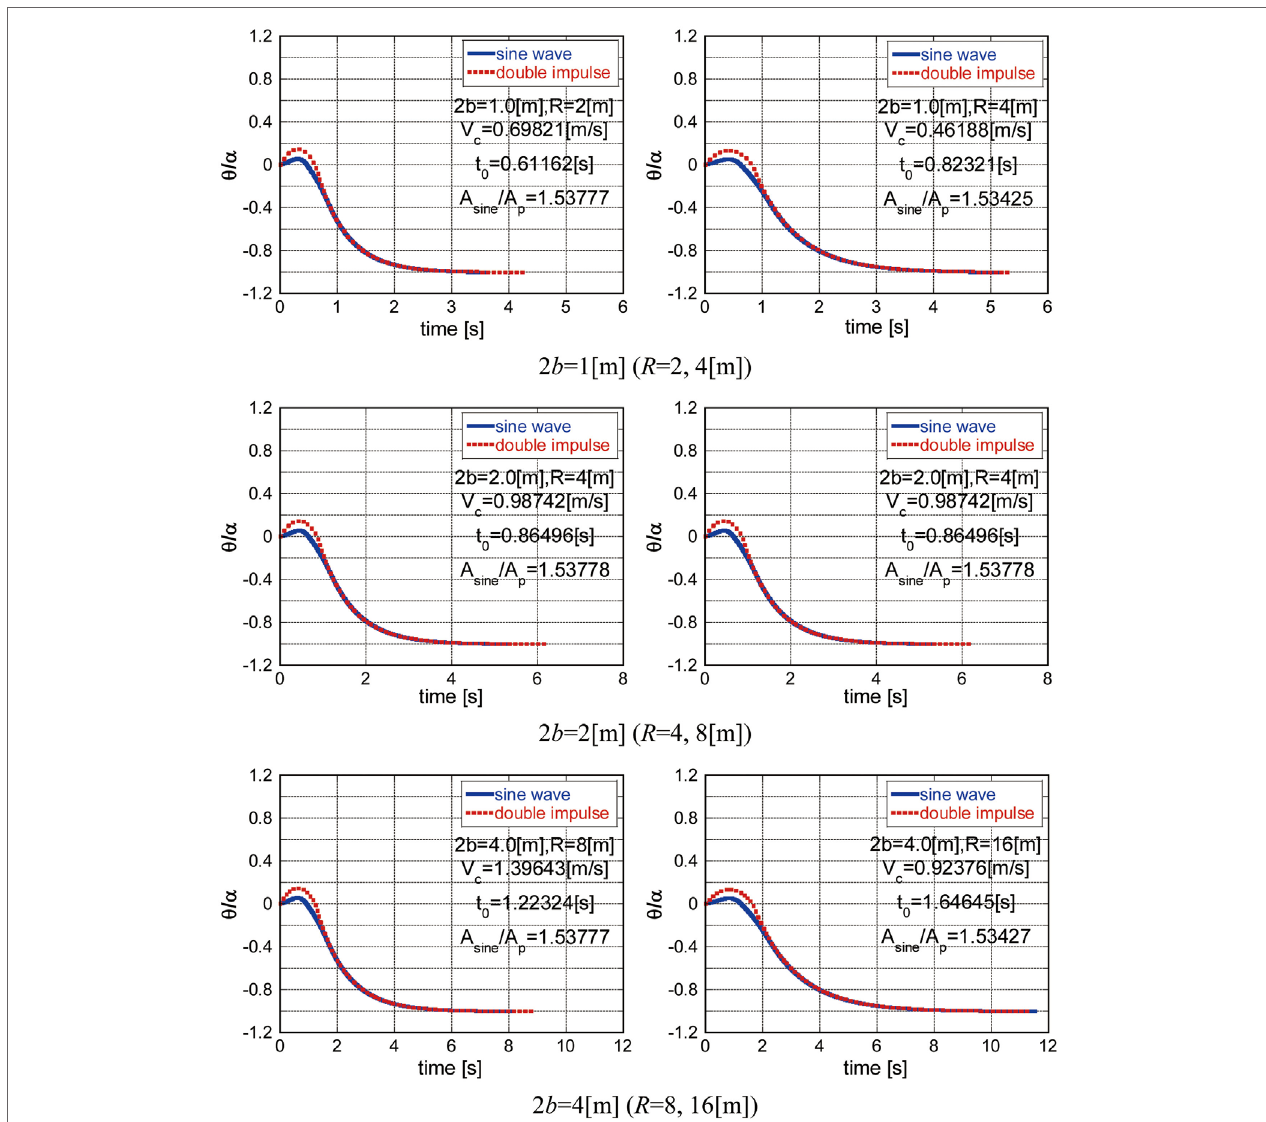
FigUre 11 | comparison of time-history responses θ ( t )/ α at overturning limit between the double impulse, and the corresponding equivalent one-cycle sinusoidal wave magnified by a coefficient about 1.53–1.54